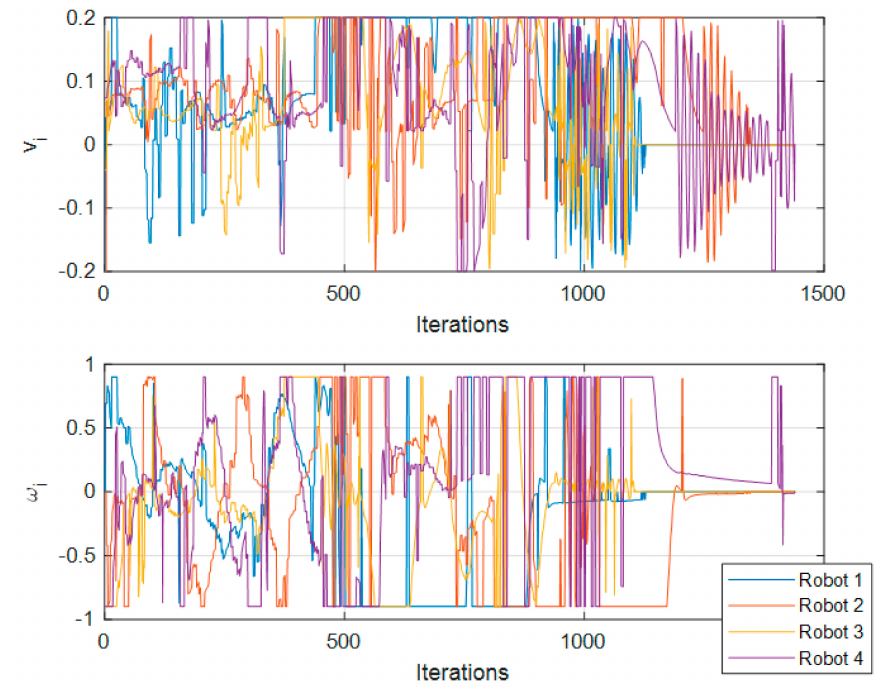
Figure 18. Input values for velocities along iterations in the 4-robot real-world test. For the 6-robot real experimental test, Figure 19 shows the trajectory followed by the 6 robots.